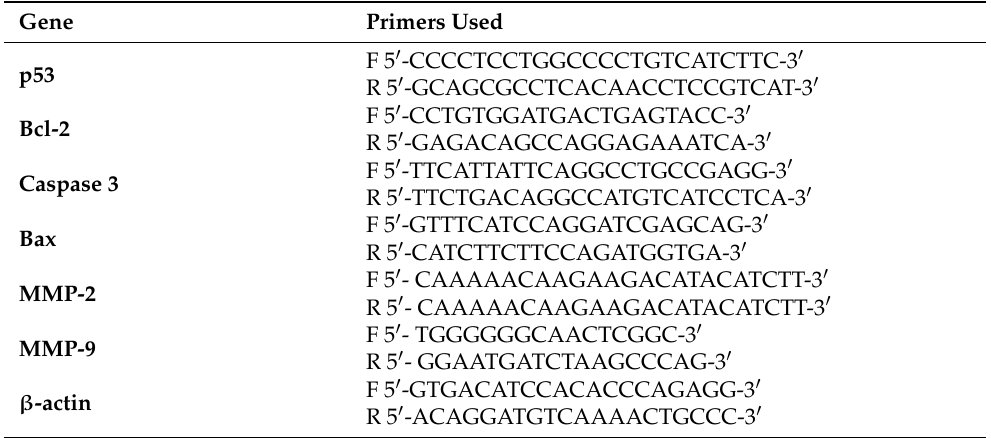
Table 6. Primers used in